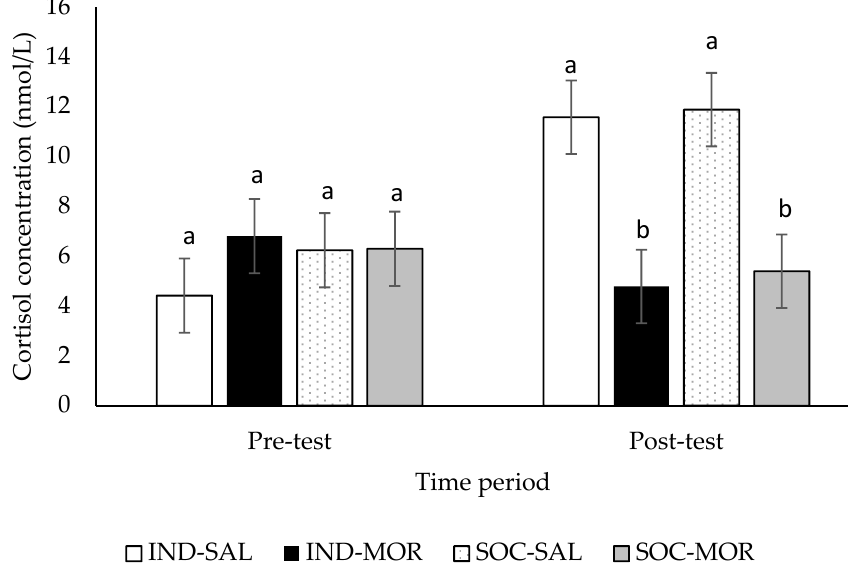
Figure 6. Cortisol concentrations (nmol/L; Least square means ± SEM) of calves prior to and immediately after being tested in a 20 min arena test. Calves received an injection of saline and were tested individually (IND-SAL, n = 12) or in pairs (SOC-SAL, n = 12), or received an injection of morphine and were tested individually (IND-MOR, n = 12) or in pairs (SOC-MOR, n = 121). For each time category, least square means with different superscripts differ at p < 0.05.